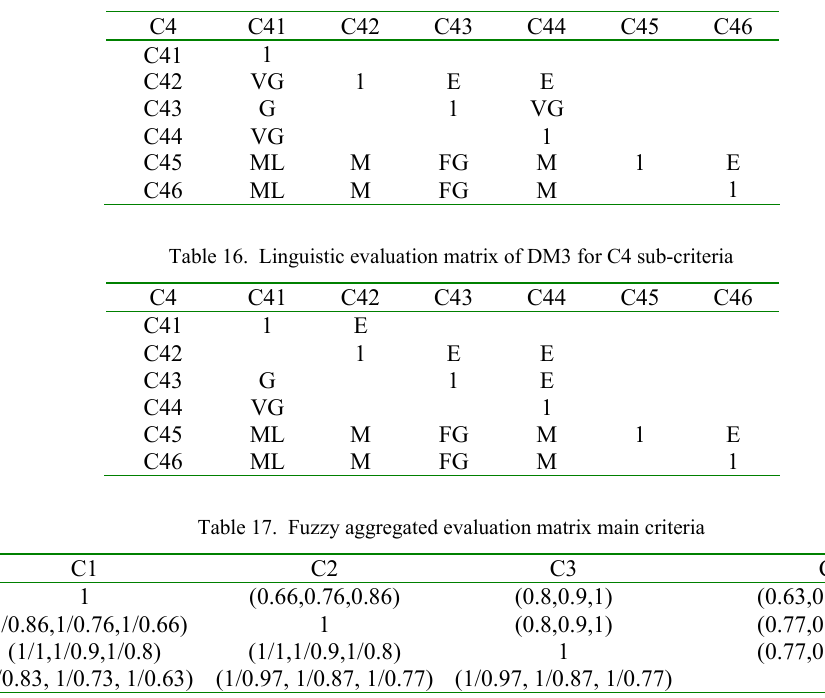
Table 15. Linguistic evaluation matrix of DM2 for C4 sub-criteria